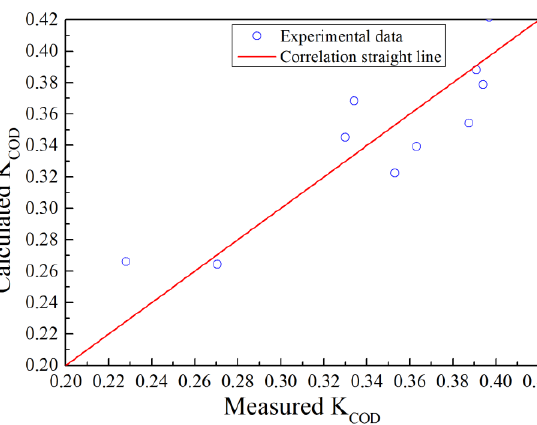
15 Table 5. Comparison between the calculated and observed values. Date